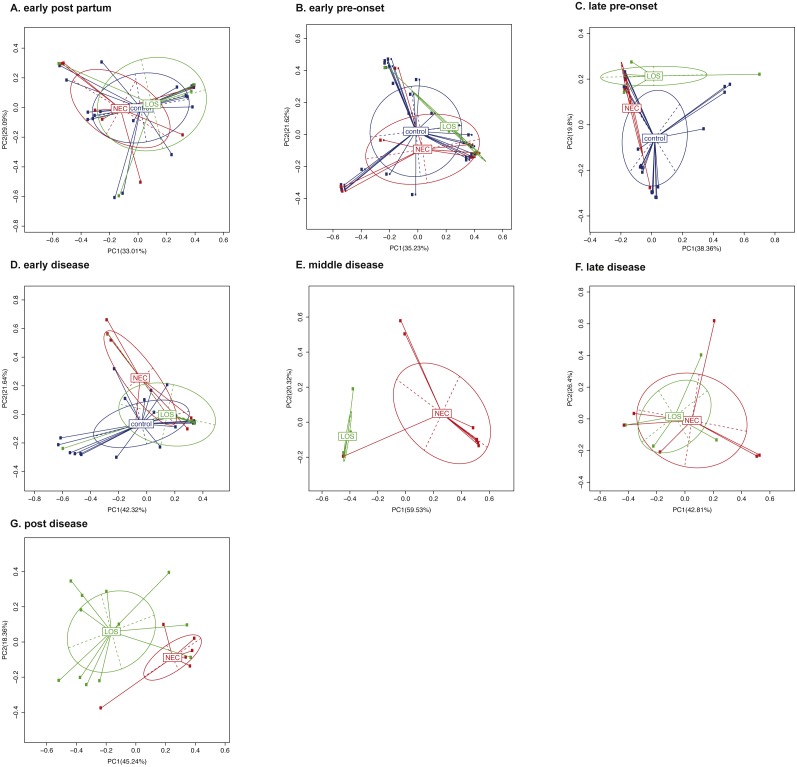
Beta diversity of the NEC, LOS and the control groups over time.(A) Early post partum; (B) early pre-onset; (C) late pre-onset; (D) early disease; (E) middle disease; (F) late disease; (G) post disease. Beta diversity of samples is depicted by principal coordinates analysis ‘PCoA’ plot showing weighted UniFrac distance between samples. Each dot represents the microbiota of a single sample. Samples from the same group is represented by the same colors. Scatter plot shows principal coordinate 1 (PC1) versus principal coordinate 2 (PC2). Percentages shown are percentages of variation explained by the components. Samples that clustered closer together are considered to share a higher proportion of the phylogenetic tree and represented by a higher percentage in PC1.